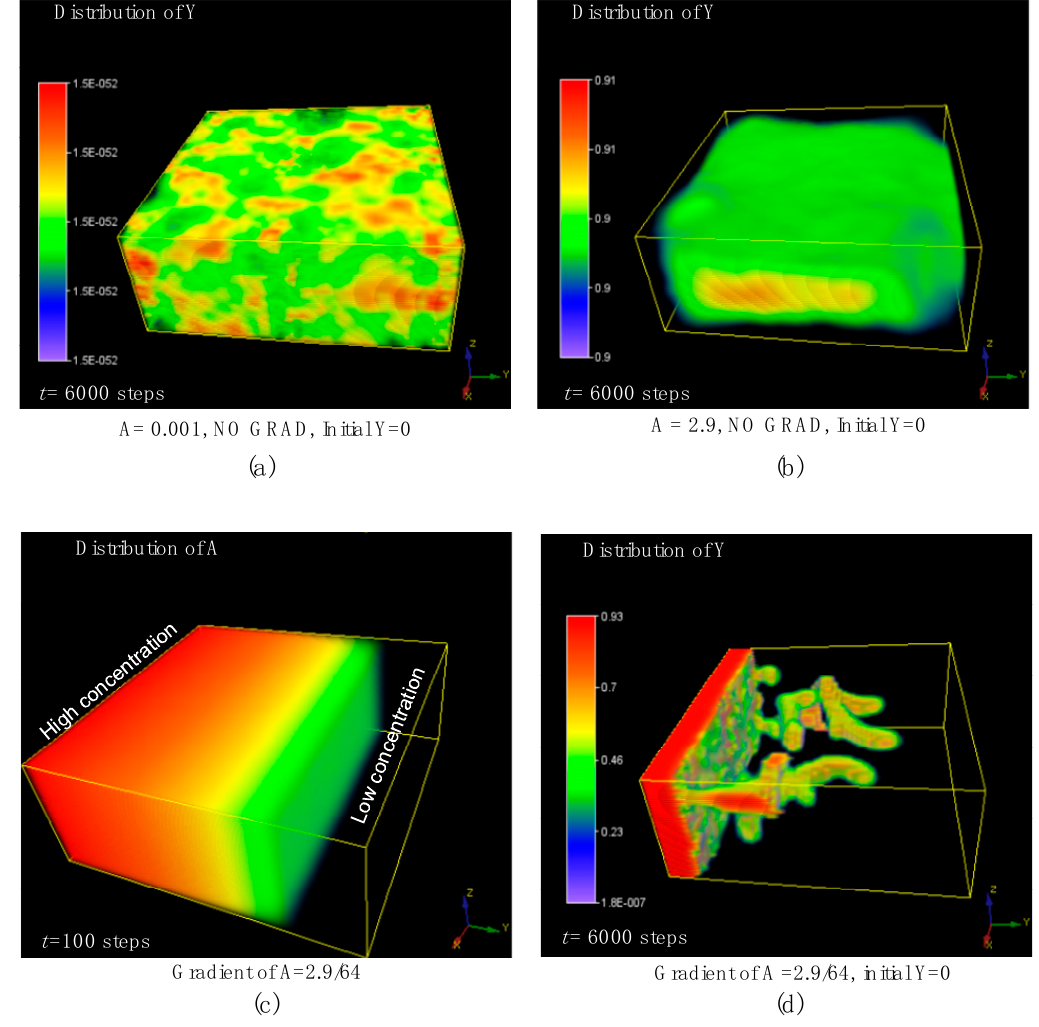
Figure 8. The effect of the external imposed concentration gradient of activator A . ( a , b ) show the simulation results of the control group without any concentration gradient by setting the average A equals to 0.001 ( a ) and 2.9 ( b ), respectively. ( c , d ) show the simulation results of the external concentration gradient of A at 100 steps ( c ) and the branching structure under this concentration gradient of A ( d ). The simulation was performed in a 64 × 64 × 32 domain. Initially, all positions in the whole volume were set to Y = 0, meaning that all the positions did not contain any differentiated cells. Parameters: c = 0.04, µ = 0.48, v = 0.06, ρ A = 0.03, ρ H = 0.0001, c 0 = 0.02, γ = 0.02, ε = 0.042, d = 0.008, e = 0.1, f = 10, D A = 0.1, D H = 0.26, D S = 0.06.